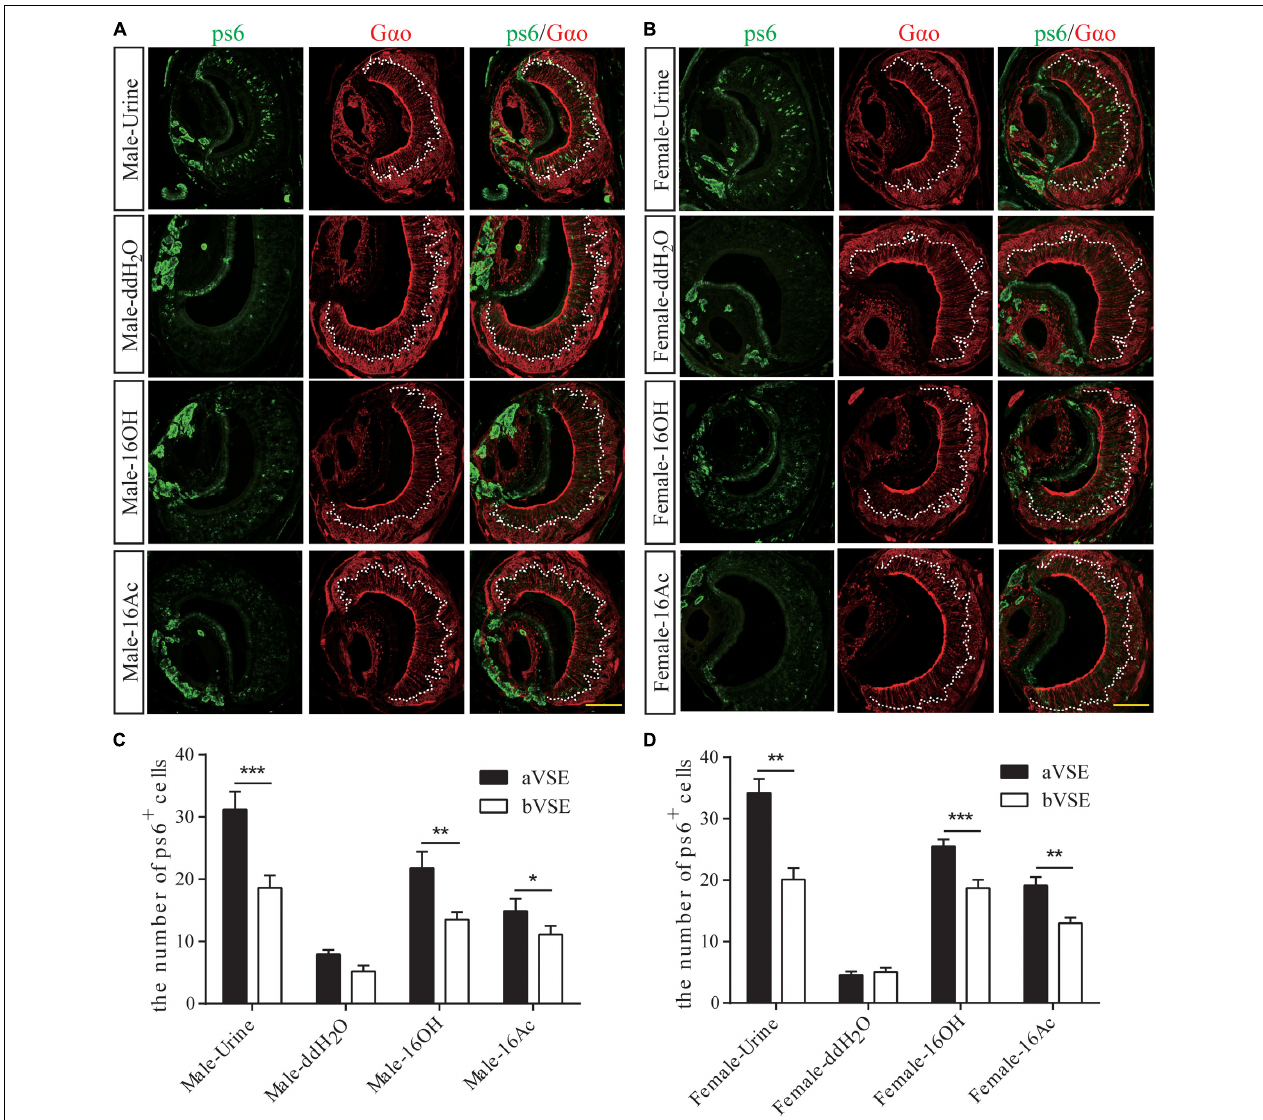
FIGURE 5 | Most responsive neurons are apical VSNs. (A,B) Images of anti-pS6 and anti-G α o double immunostaining on male and female VNO sections, respectively, following the exposure to 100 µ M 16OH, 100 µ M 16Ac, urine (positive control), or double distilled water containing 0.01% DCM (ddH 2 O, negative control). (C,D) Comparative analysis of the double immunostaining data from both the male and female VNO sections, respectively, showed that significantly more pS6-positive neurons were located in the apical VSE (aVSE) than in the basal VSE (bVSE) upon stimulation of urine, 16OH, or 16Ac (aVSE vs. bVSE: male-urine, t = 6.350, p = 0.000; male-16OH, t = 3.275, p = 0.010; male-16Ac, t = 2.604, p = 0.029; female-urine, t = 4.462, p = 0.002; female-16OH, t = 6.464, p = 0.000; female-16Ac, t = 4.620, p = 0.001). All values are expressed as mean ± s.e.m. ∗ p < 0.05, ∗∗ p < 0.01, ∗∗∗ p <